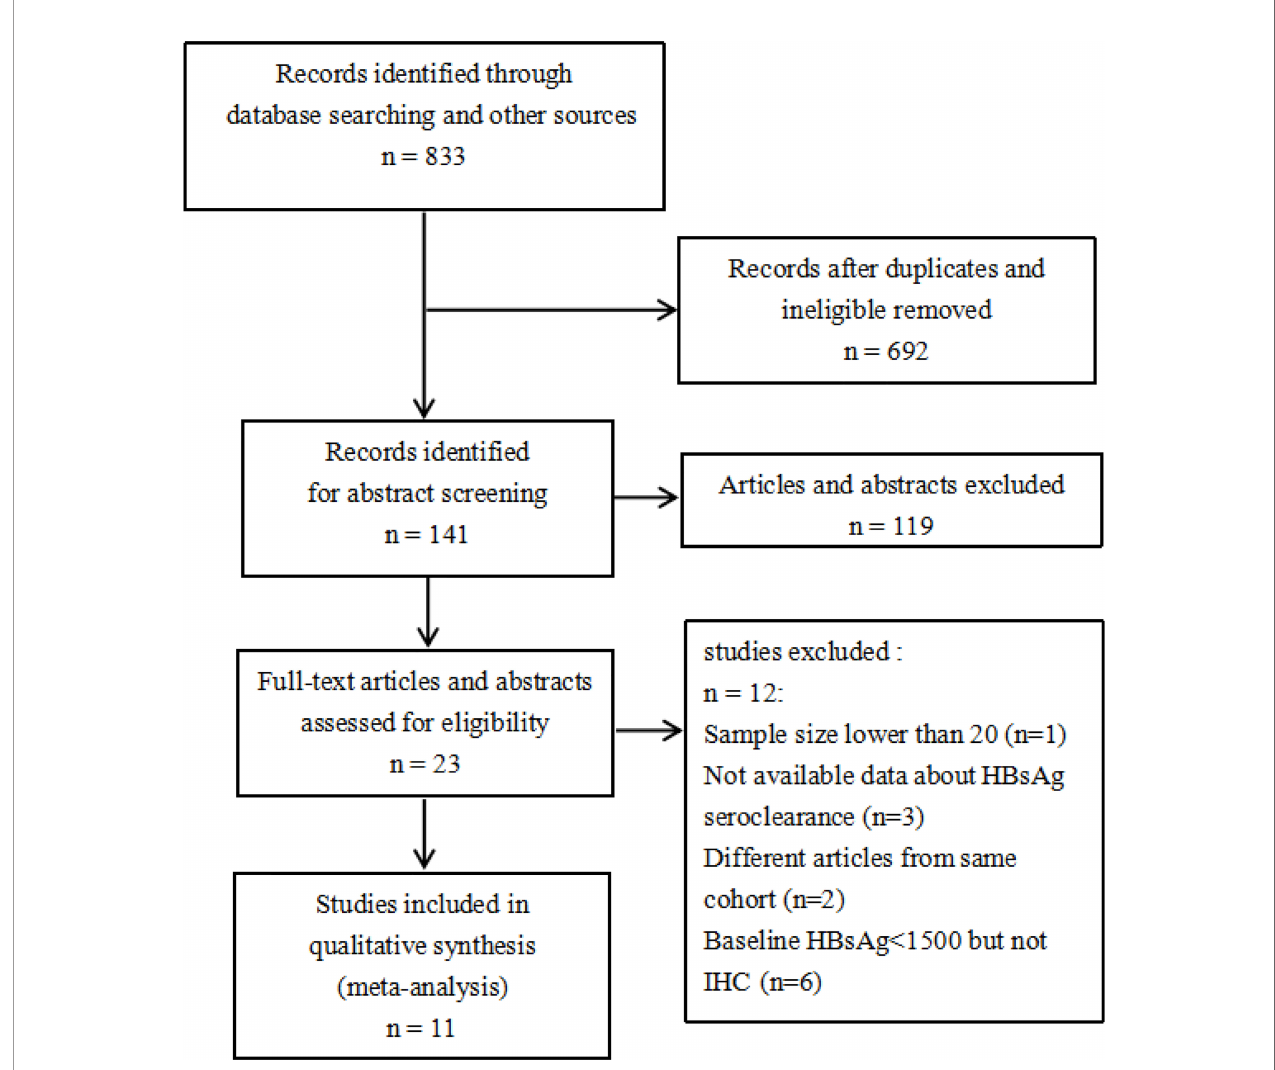
FIGURE 1 | Study selection